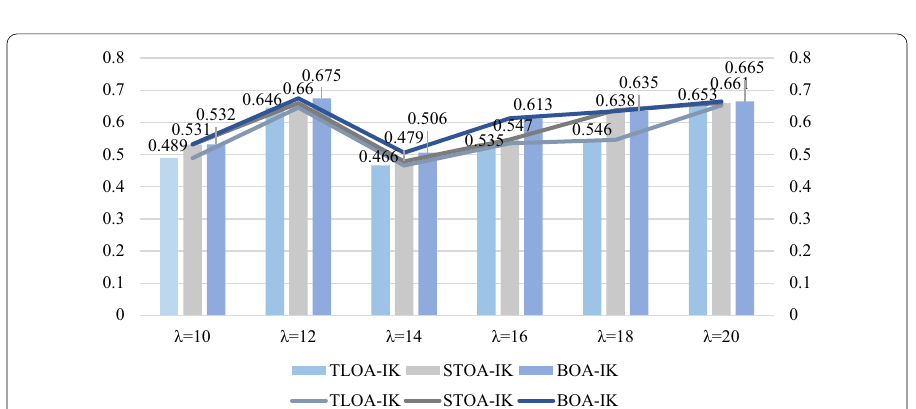
Fig. 8 Trajectory length and sum-throughput performance of each algorithm under different DU